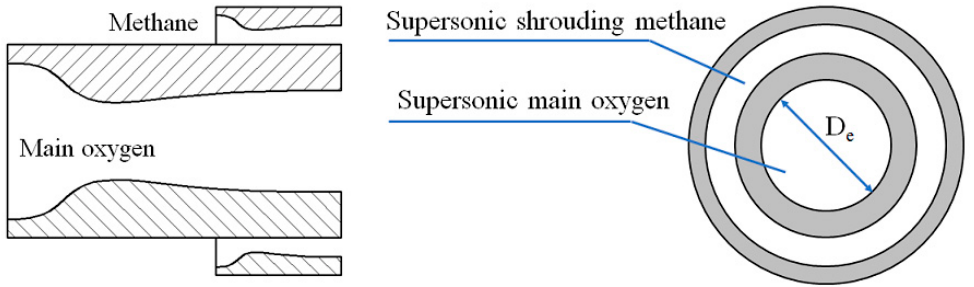
Figure 1. Structure of the supersonic combustion coherent jet nozzle.